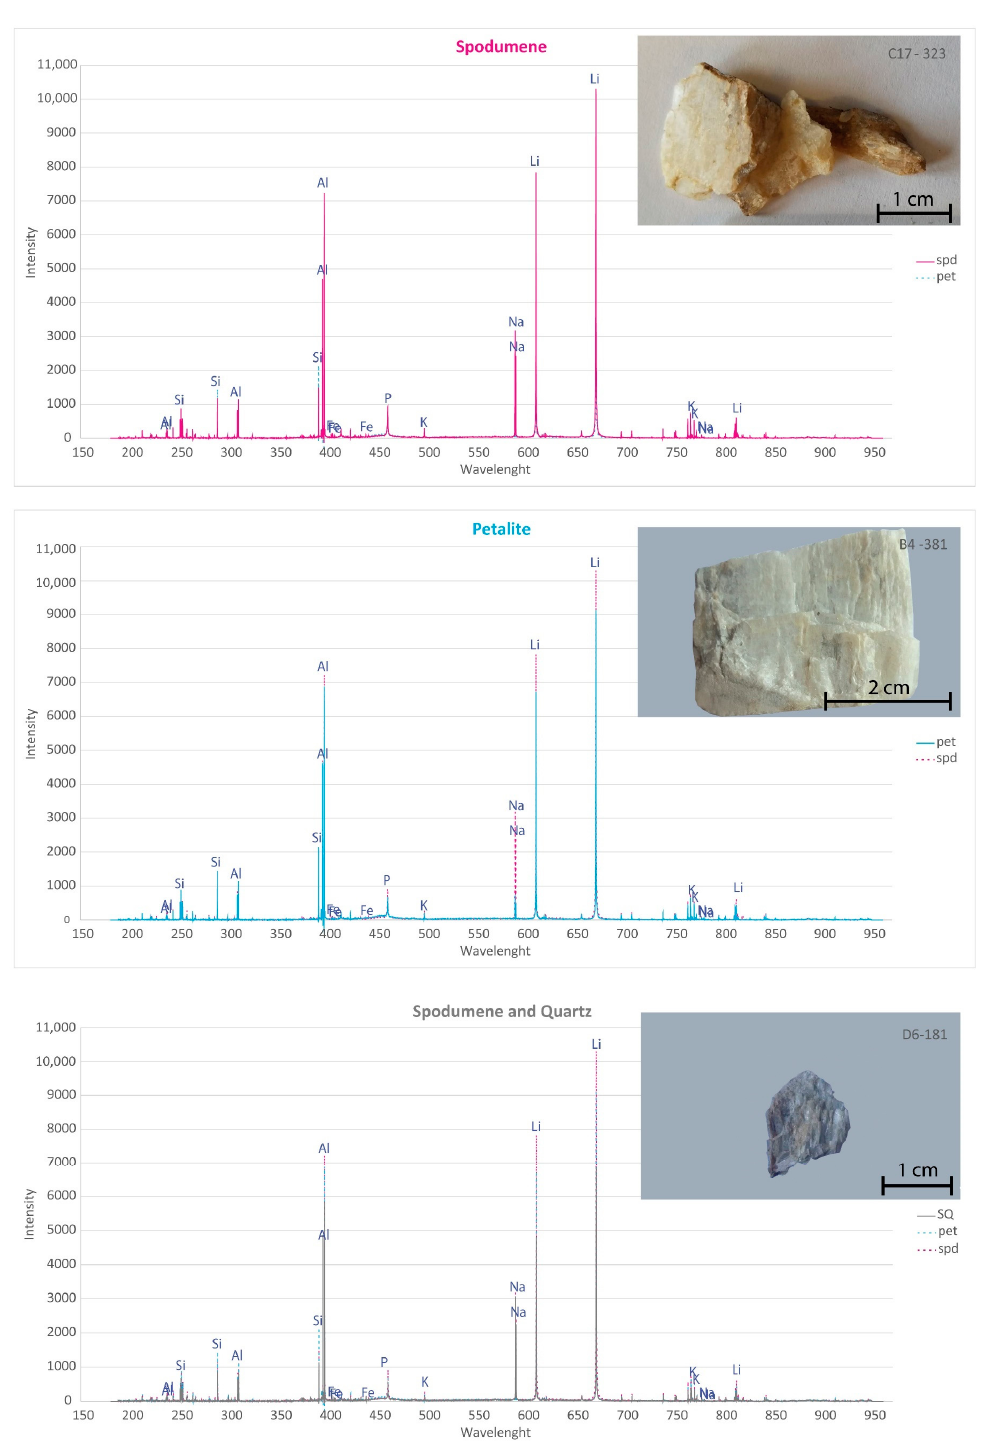
Figure A1. pLIBS spectra for the pellets of the spodumene (spd) sample 32-C3 (pink spectra) compared to the petalite (pet) sample 38-B1 (blue spectra) and to the spodumene and quartz (SQ) sample 18-D1 (black spectra).